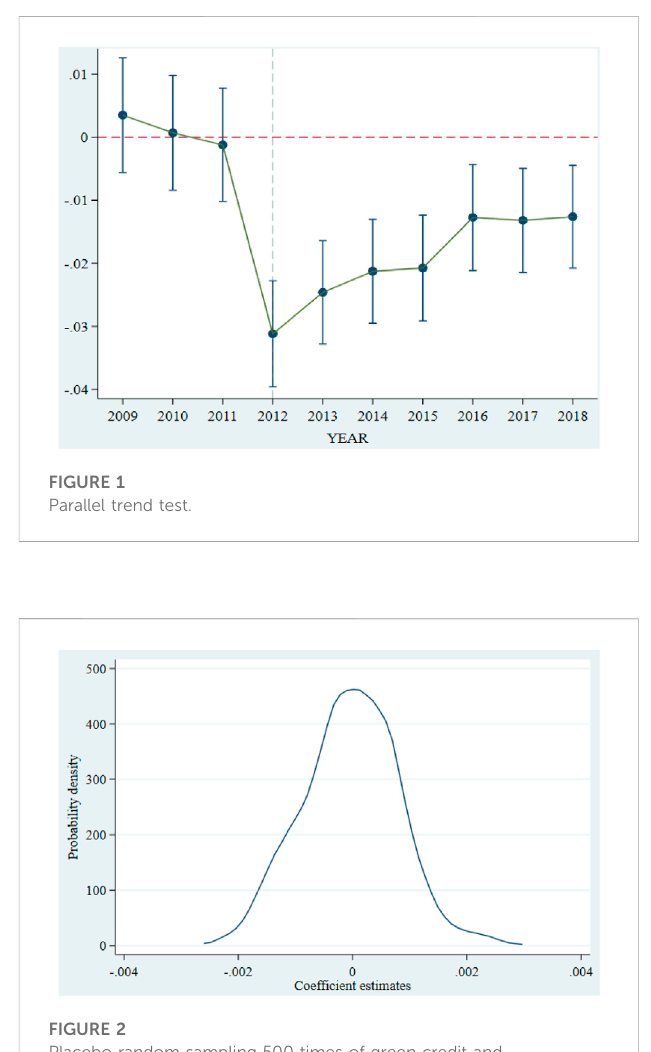
FIGURE 2 Placebo random sampling 500 times of green credit and fi nancialization